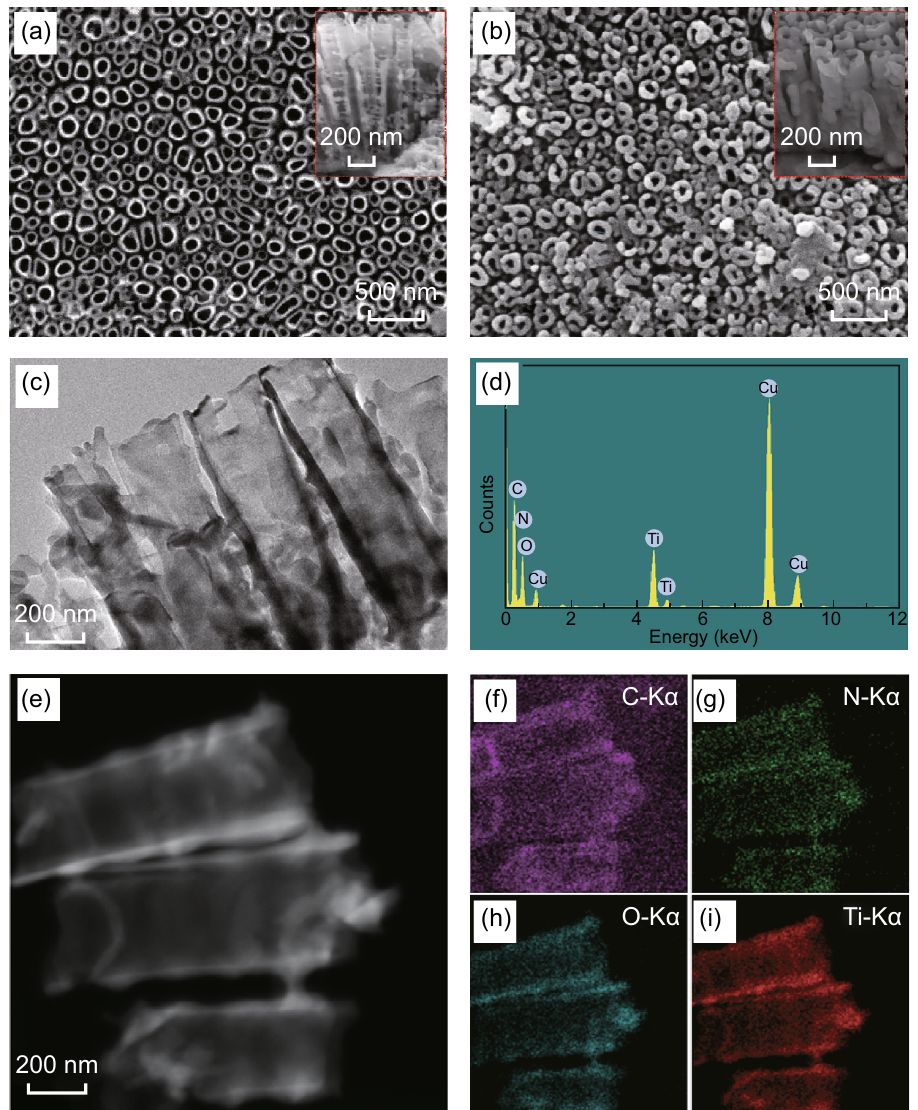
Fig. 3 SEM images of the as-synthesized a TNTAs and b g-C 3 N 4 /TNTAs. c TEM image and d EDX spectrum of g-C 3 N 4 /TNTAs. e , f Elemental mapping results of